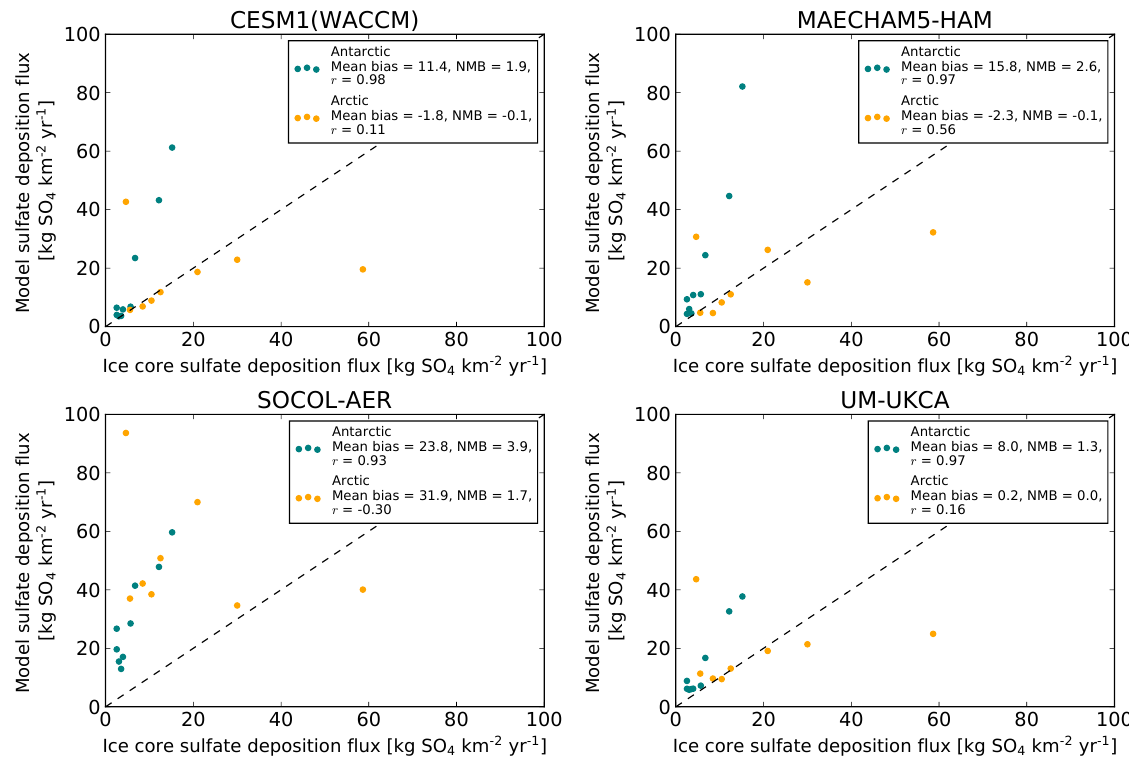
Figure 3. Scatter plots of preindustrial background ice core sulfate deposition fluxes vs. simulated preindustrial sulfate fluxes (kgSO 4 km − 2 yr − 1 ) in the Antarctic (teal points) and in the Arctic (orange points) for each model. Simulated values represent the grid box value where each ice core is located. The dashed line marks the 1 : 1 line. Included in the legends are the mean bias, normalized mean bias (NMB) and the correlation coefficient ( r ) for the Antarctic and